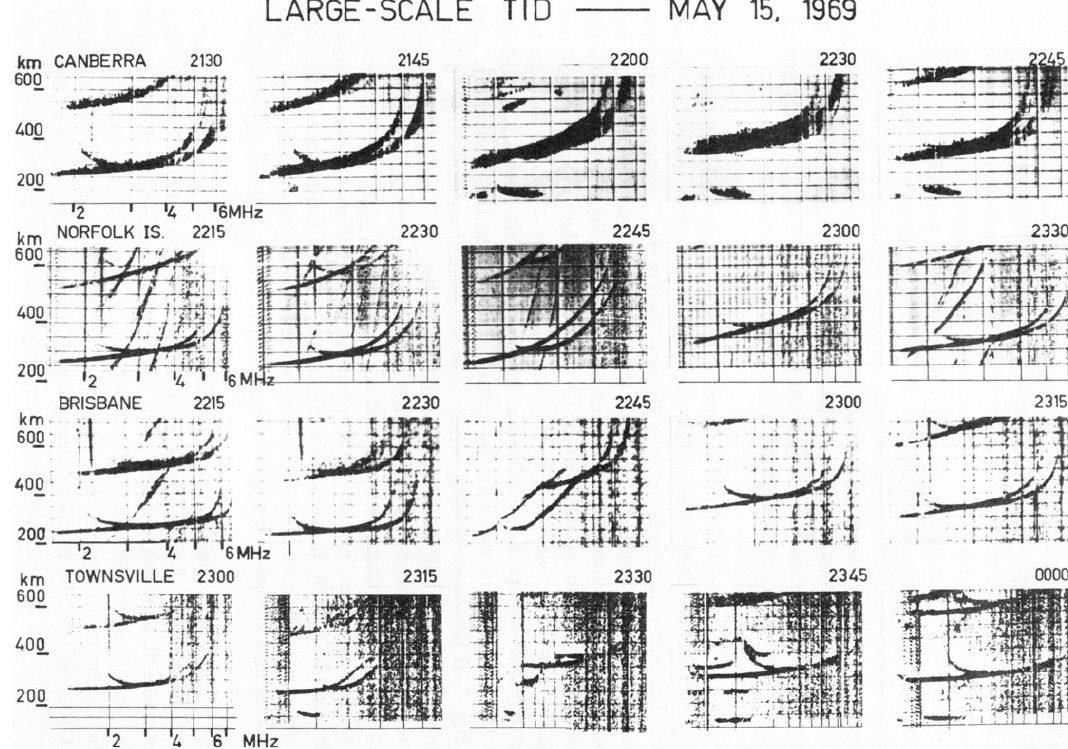
Fig. 4. A reproduction of Fig. 5 of Bowman (1990) showing LS-TID propagation at 4 Australian stations. Distorted ionogram traces include one (Brisbane, 2245) which shows F 1 and F 2 layer